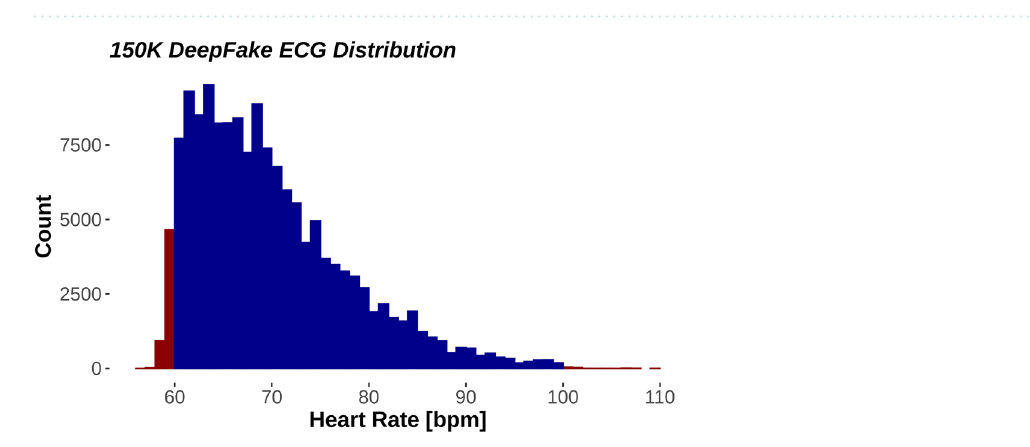
Figure 2. Distribution of heart rates in all 150,000 DeepFake electrocardiograms. Red fill denotes outside the normal heart rate range. Blue fill is within normal heart rate range (60–99).